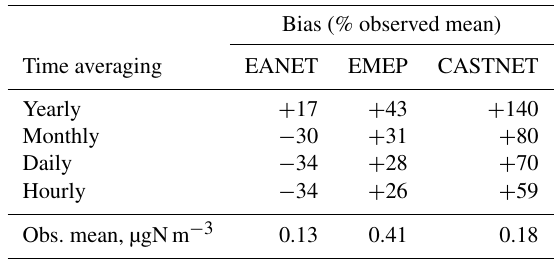
Table 3. Bias (percent relative to observed) simulated NO centration for 2010 as affected by temporal averaging of NH 3 emis- sions. The biases are evaluated for the EANET, EMEP and CAST- NET